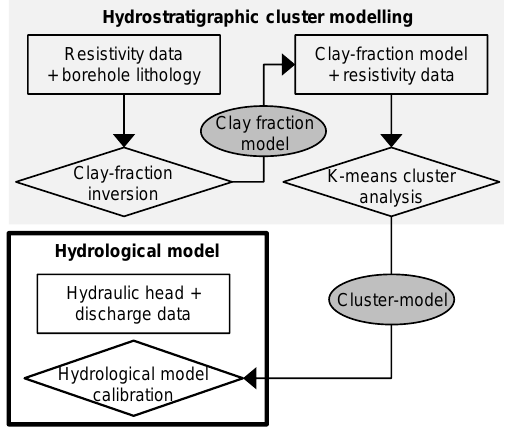
Figure 1. Workflow of the two main parts in the method. Top grey box: hydrostratigraphic cluster modeling using the structural infor- mation carried in the geophysical data and lithological information. Lower box in bold: hydrological calibration where hydraulic prop- erties of the hydrostratigraphic zones are estimated using hydrolog- ical